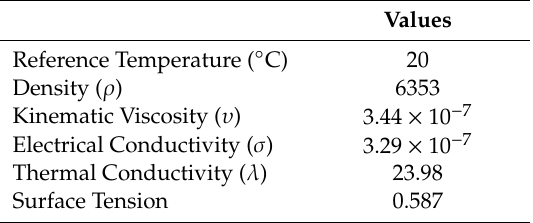
Figure 4. Schematic of mold illustrating the position of the sensors and electromagnetic brake. Table 1. Physical properties of gallium-indium-tin [17].